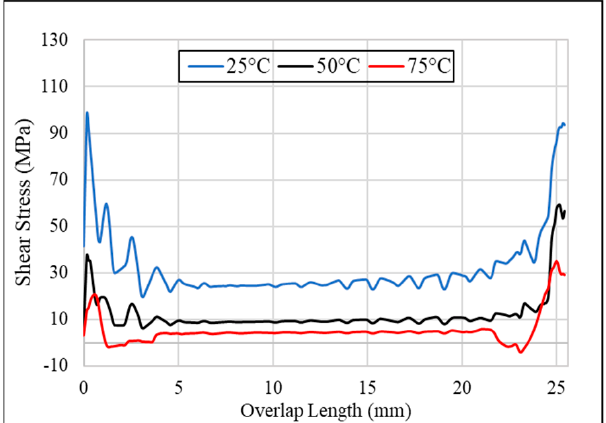
Figure 18. Shear stress distribution at location A of SLJ with Al 2 O 3 nanoparticles in the adhesive at different temperatures.